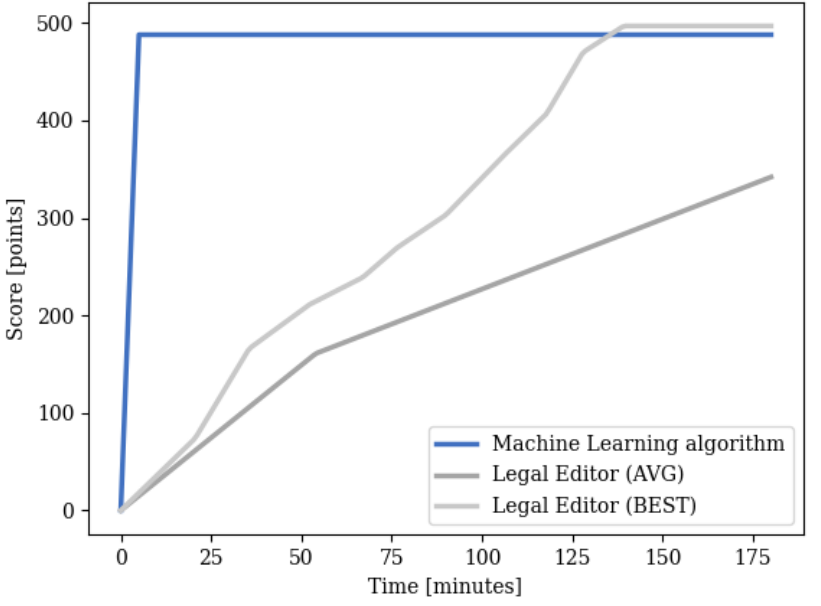
Figure 7. The performance of the best-performing legal editor and the group of legal editors who got unlabeled judgments over